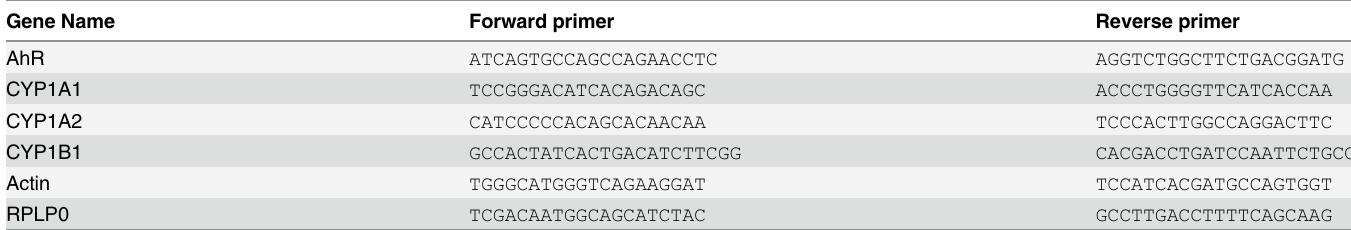
min, 40 cycles of denaturation at 95°C for 10 sec, annealing at 65°C for 15 sec and elongation at 72°C for 15 sec. The amplification specificity was evaluated by determining the product melting curve. Results are expressed as indicated in the figure legends. Primer sequences are given in Table 2. The relative mRNA expression was normalized to the expression of β -actin and ribosomal protein large P0 (RPLP0), as recommended by Vandesompele et al [28]. The Ct-values for β - actin and RPLP0 were not affected by any of the